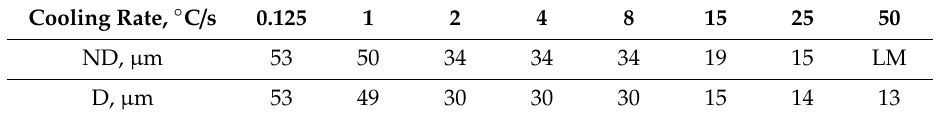
Table 2. Grain size diameter as a function of the cooling rate for non-deformed and deformed samples.